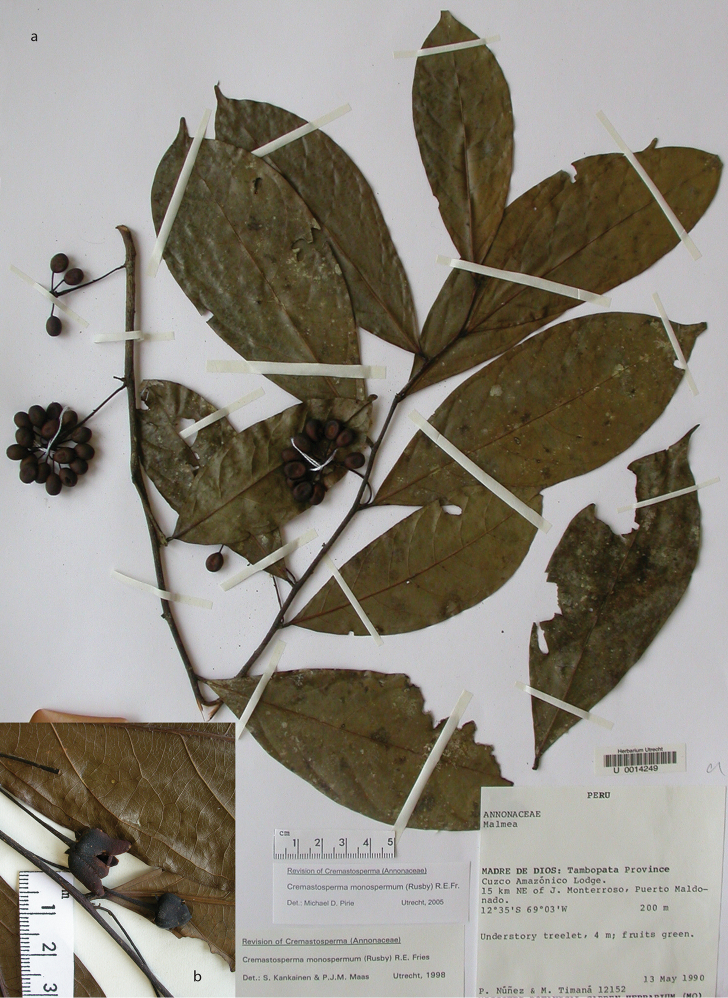
Cremastospermamonospermum (Rusby) R.E.Fr. a fruiting specimen b flower buds (aNuñez & Timaná 12152bCid Ferreira et al. 6301).